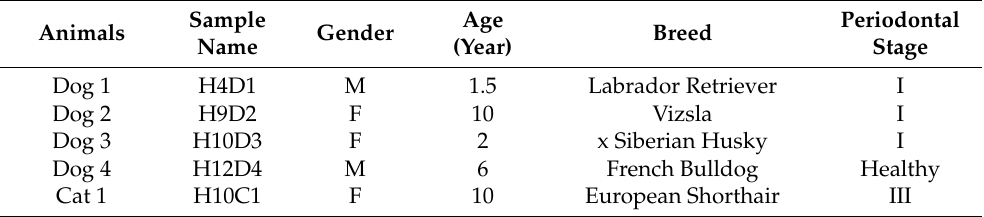
Table 3. Basic information and periodontal status of the companion